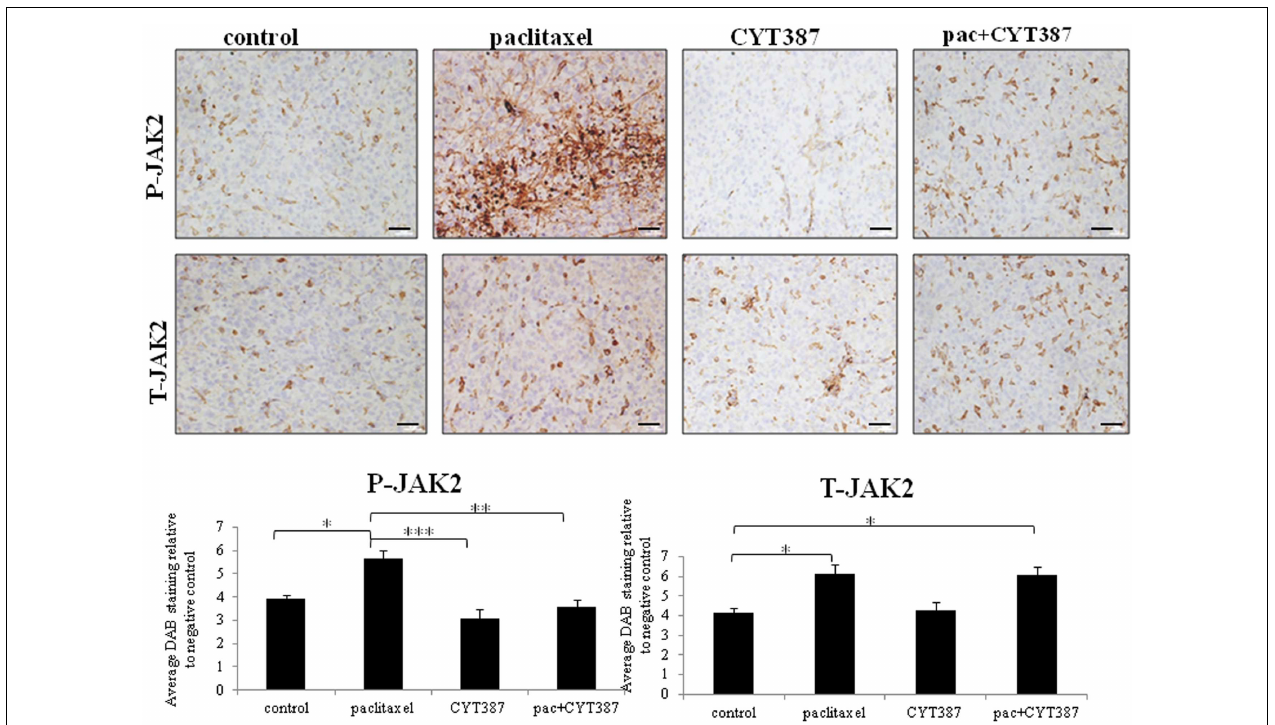
“Materials and Methods.” Magnification 200 × , scale bar = 10 µ M. Average DAB intensity and proportion of staining of P-JAK2 orT-JAK2 in xenografts was standardized to a negative control.The quantification was derived from the staining of five independent xenografts in each group. Significant intergroup variations are indicted by * p < 0.05, ** p < 0.01, and *** p <